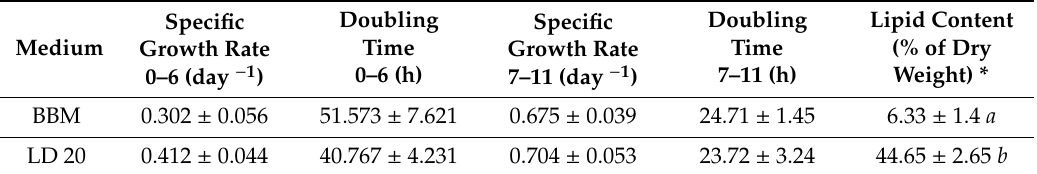
Table 1. E ff ects of the substrate on the specific growth rate, doubling time, and lipid content in A. protothecoides . Data are means ( ± SDs) of nine measurements.